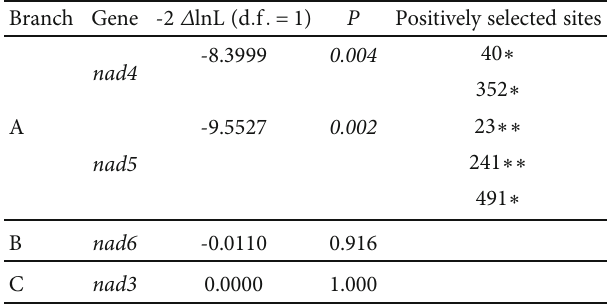
Table 4: Results of branch-site model analyses in Plethodontidae. Branch Gene -2 Δ lnL ( d : f : = 1